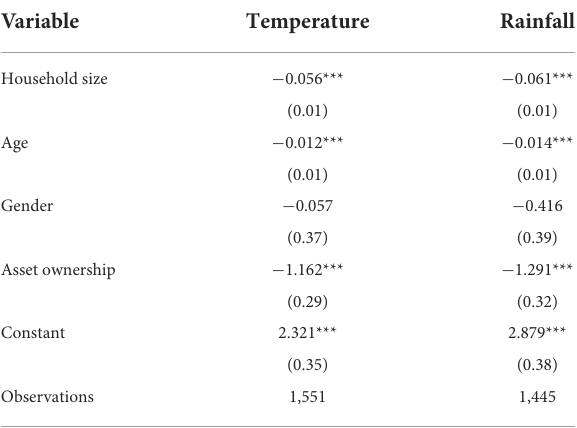
TABLE 5 Regression results of factors determining alignment over a 7-year timeframe.